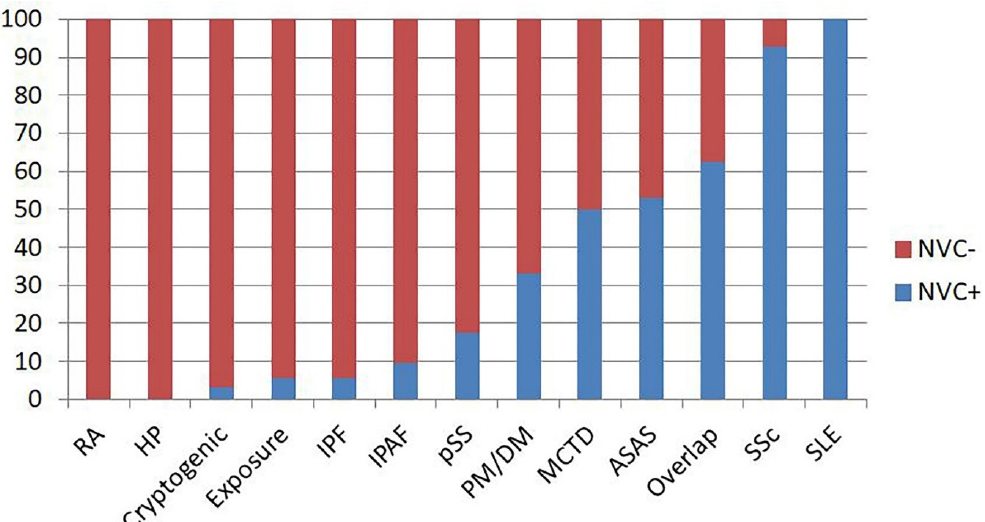
Figure 2. Proportion of nailfold videocapillaroscopy (NVC) positivity for each diagnosis in interstitial lung disease (ILD) patients. ASAS: antisynthetase syndromes, HP: hypersensitivity pneumonia, IPAF: interstitial pneumonia with autoimmune features, IPF: idiopathic pulmonary fibrosis, MCTD: mixed connective tissue disease, NVC: nailfold videocapillaroscopy, PM / DM: polymyositis / dermatomyositis, pSS: primary Sjögren’s syndrome, RA: rheumatoid arthritis, SLE: systemic lupus erythematosus and SSc: systemic